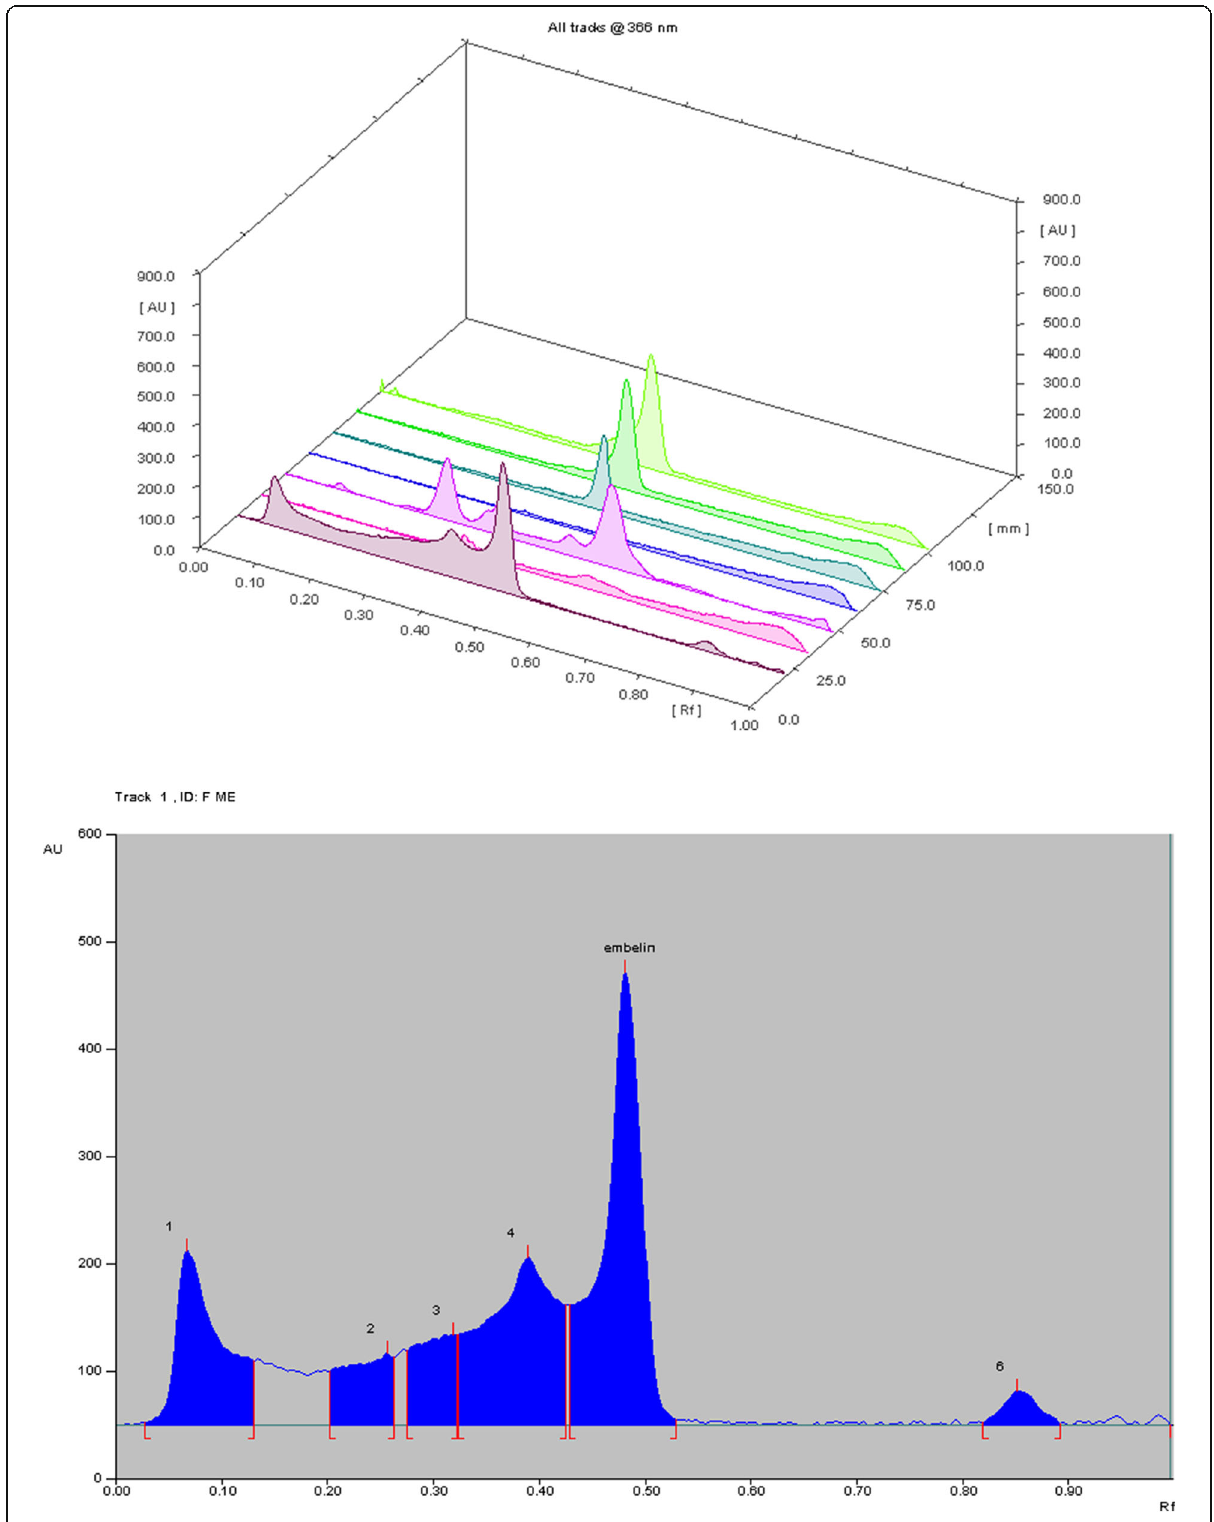
Fig. 7 Chromatogram of n-Hexane extract of E. gardneriana and Embelin under 366